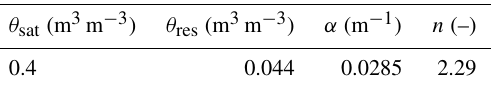
Table B1. Soil retention curve and parameters’ optimized